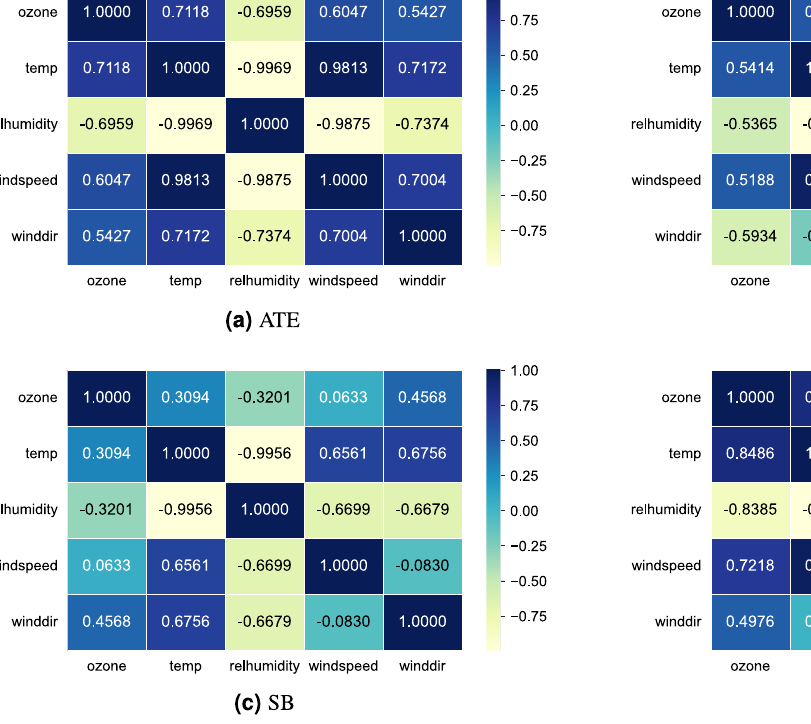
Figure 2. Correlation matrices considering mean between the meteorological variables and the ozone for each monitoring station. This correlational analysis allows evaluating the associations between the variables under study. The reported values oscillate between − 1 and 1, when there is a negative and positive association,